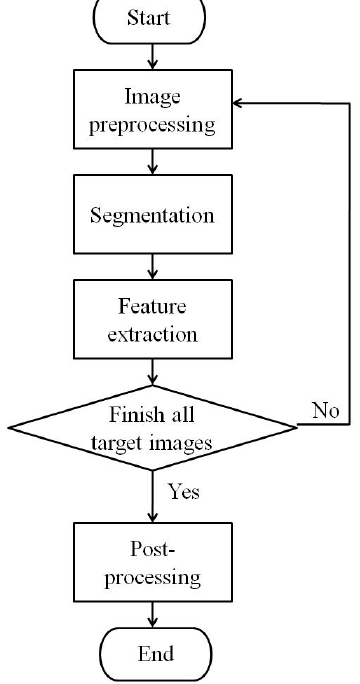
Figure 5. Flowchart of image processing procedure.